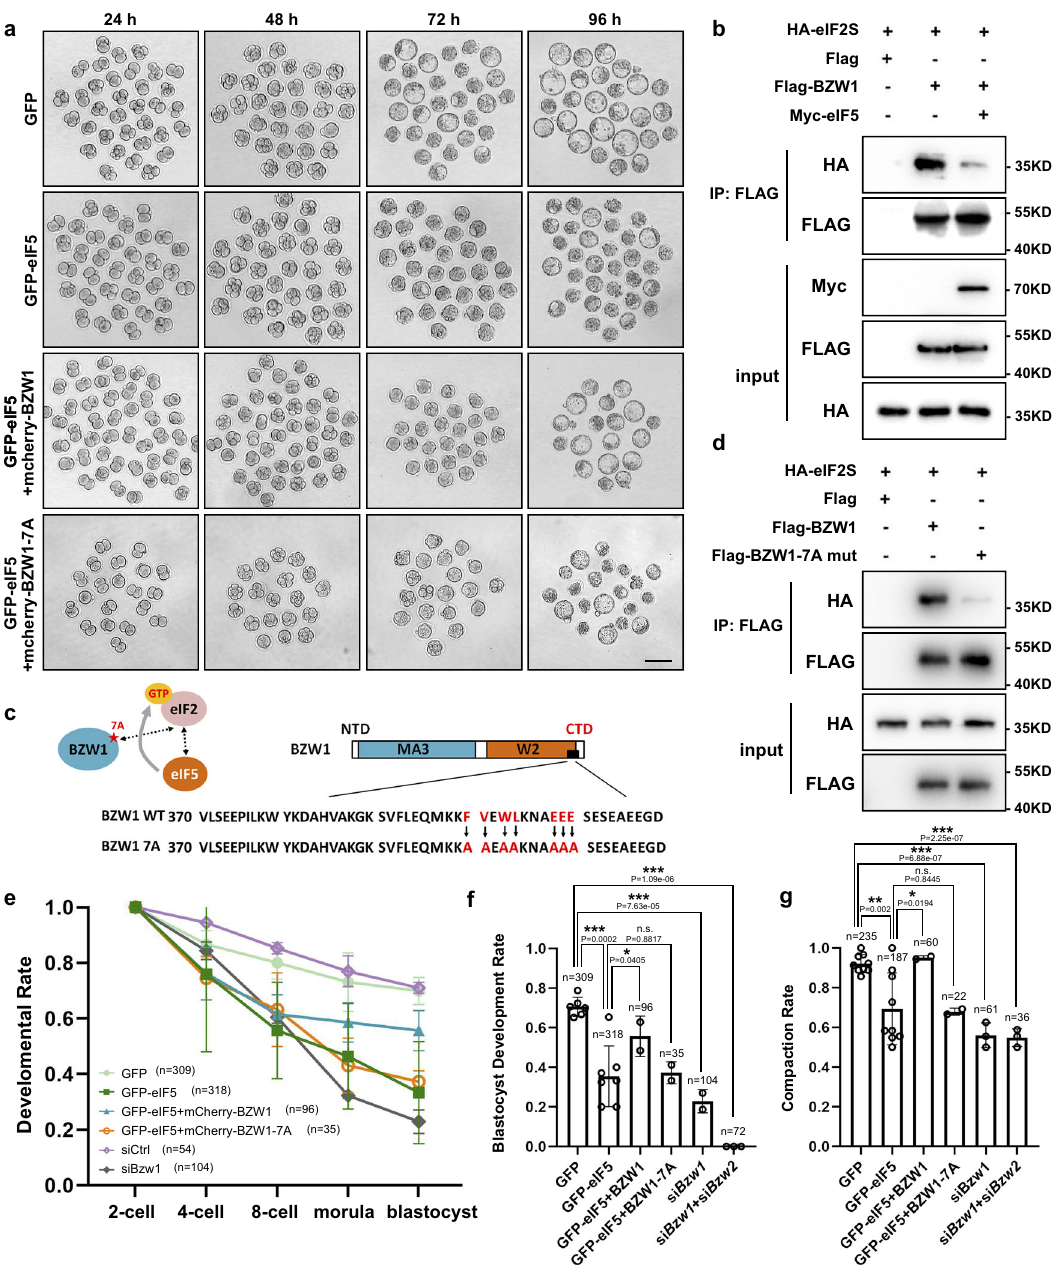
Fig. 6 | BZW1 promotes preimplantation embryonic development and com- paction by competing with eIF5. a Representative embryo images of embryos at 24, 48, 72, and 96h after microinjection in zygotes. These were respectively microinjected with mRNAs encoding GFP (as control), GFP-eIF5, GFP-eIF5 and mCherry-BZW1, or GFP-eIF5 and mCherry-BZW1-7A mutants. Scale bar, 100 μ m. b Co-immunoprecipitation (Co-IP) experiments showing interactions of the eIF2subunit with BZW1 with or without eIF5overexpression. HeLacells transiently transfected with plasmids encoding the indicated proteins were lysed and sub- jected to immunoprecipitation with ananti-FLAGaf fi nity gel.Input celllysates and precipitates were immunoblotted with antibodies against FLAG and HA. c Amino acid sequence in BZW1-7A mutant CTD. The experiment was repeated two times with similar results. d Co-IP experiment demonstrating interactions of the eIF2 subunit with BZW1 or BZW1-7A mutants. The experiment was repeated three